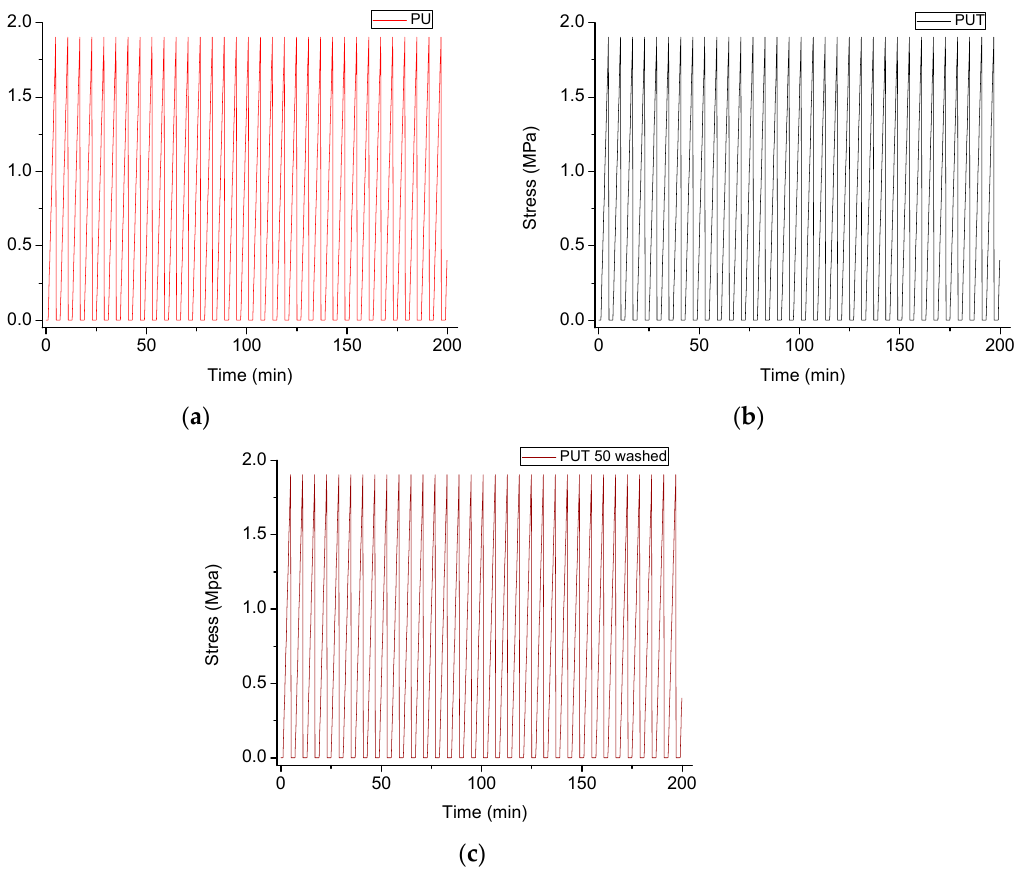
Figure 6. Stress–time curves for 33 deformation cycles of ( a ) pristine PU foams, ( b ) functionalized PUT foams, and ( c ) functionalized PUT foams after 50 washing cycles.